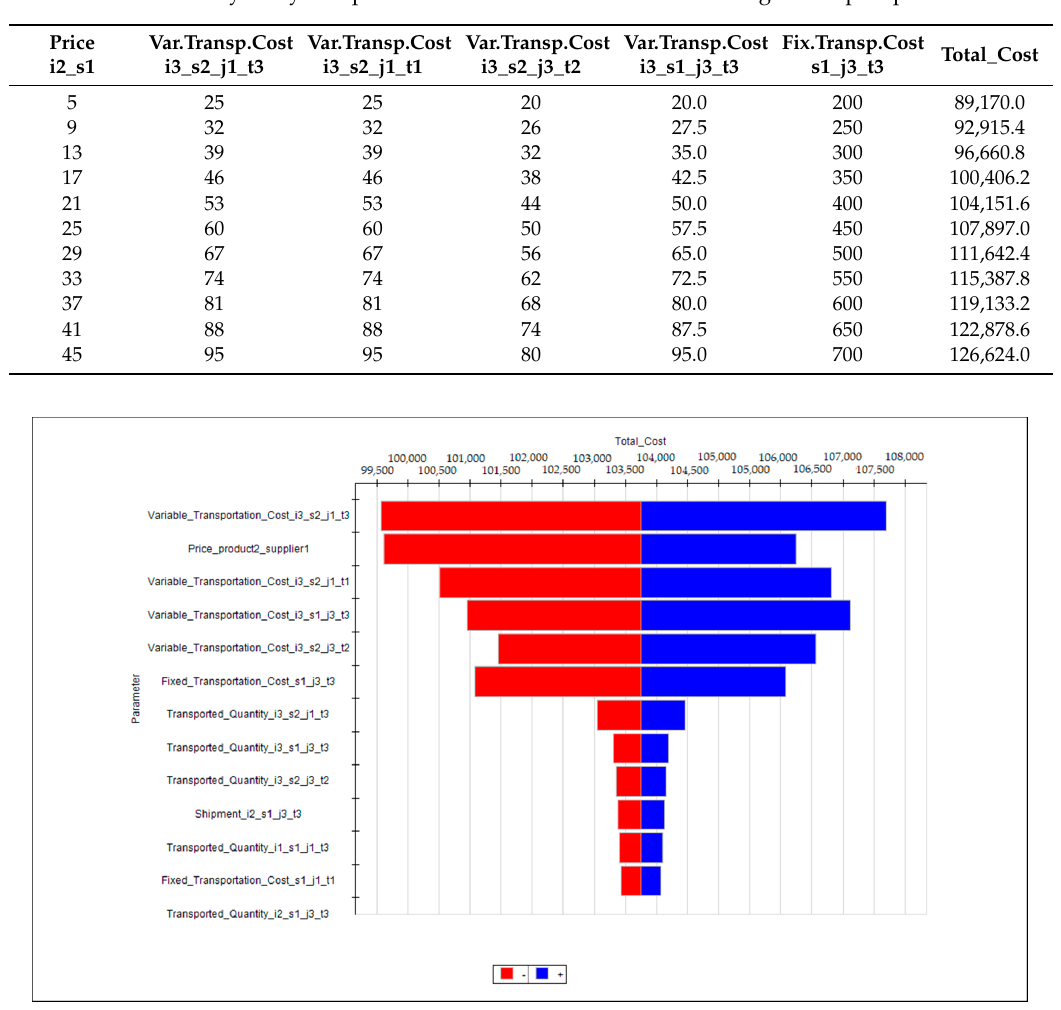
Table 3. Sensitivity analysis report for simultaneous variations in the highest-impact parameters.